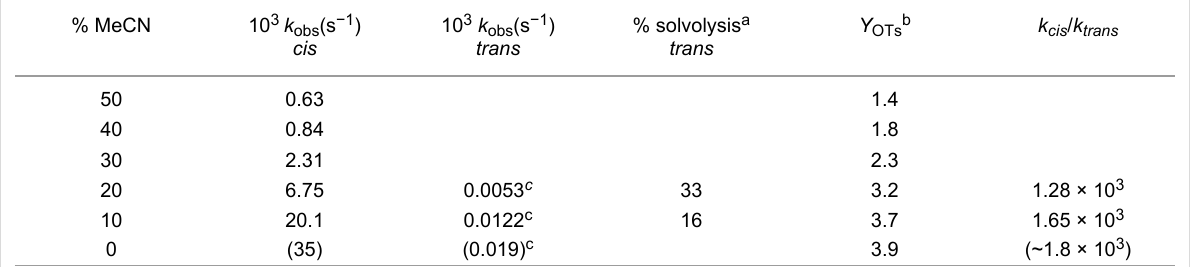
Table 1: Rate constants for solvolysis of cis - and trans -1-trichloroacetoxy-2-methoxy-1,2-dihydronaphthalene ( 3 ) in acetonitrile-water mixtures at 25 °C. % MeCN 10 3 k obs (s − 1 )